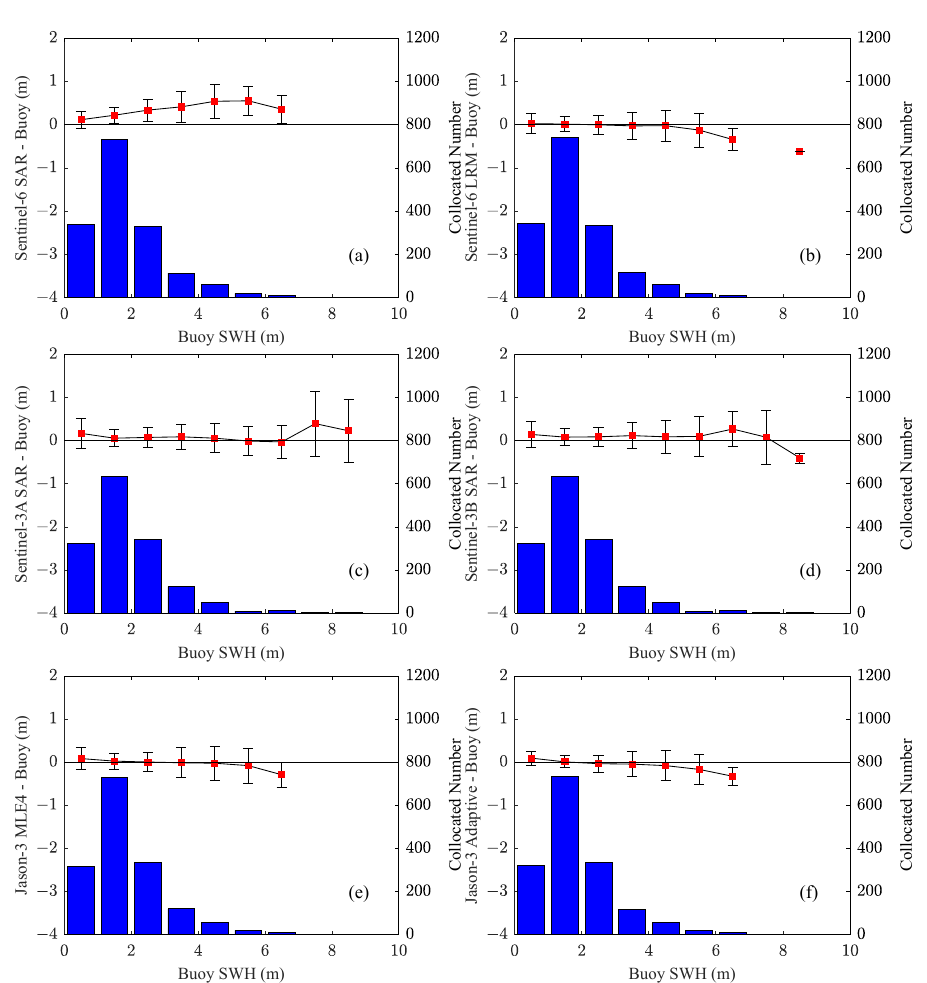
Figure 10. Bias dependency of altimeters and buoy SWH measurements for ( a ) Sentinel-6 SARM, ( b ) Sentinel-6 LRM, ( c ) Sentinel-3A SARM, ( d ) Sentinel-3B SARM, ( e ) Jason-3 MLE4 and ( f ) Jason-3 adaptive SWH measurements.